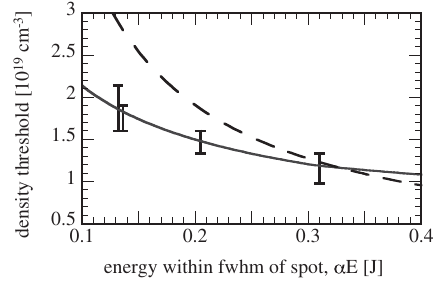
FIG. 4. Observed density threshold as a function of laser energy ( (cid:1)E ) for our experiment. The solid curve represents our threshold model. The dashed curve represents a threshold based on (cid:1)P=P c > 3